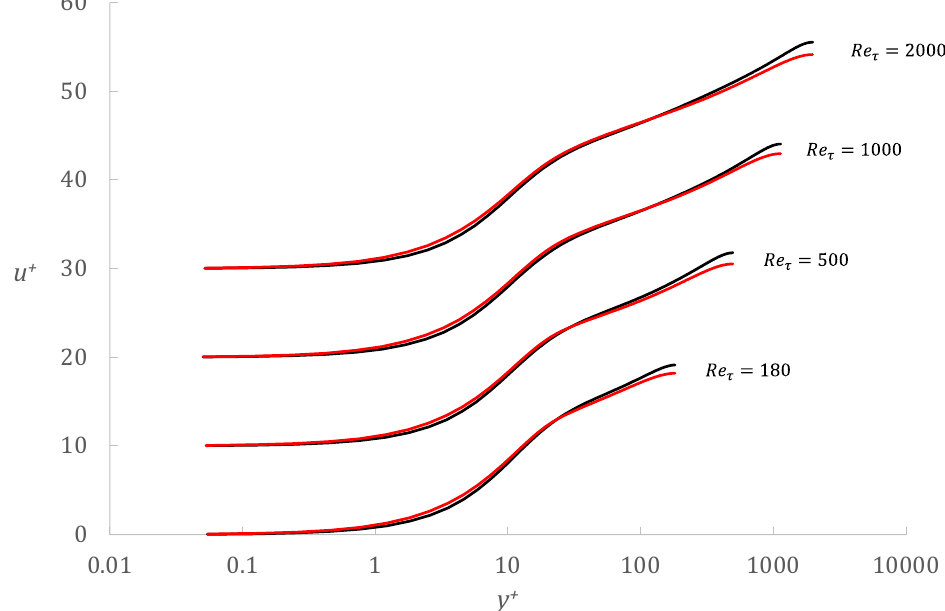
Figure 8. MVP; – DNS database [31,32]; and – channel ITM model. The plots are shifted vertically by Figure 8. MVP; ─ DNS database [31,32]; and ─ channel ITM model. The plots are shifted vertically 10 by 10 units.